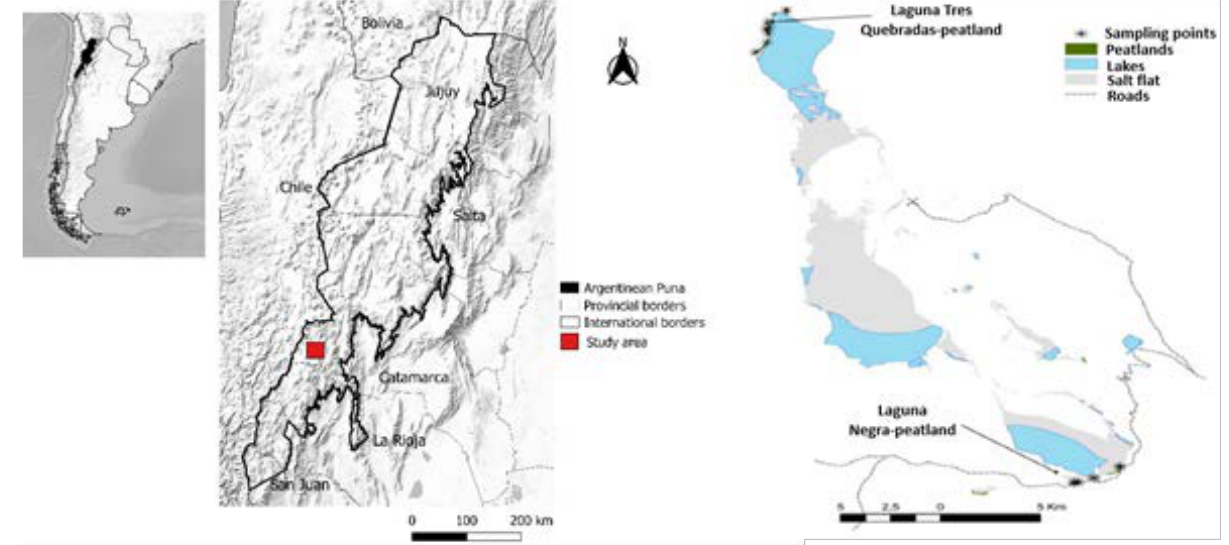
Figure 1. Location of the study area in the Puna ecoregion, within Catamarca province in Argentina (left). Salt flat associated with lakes and peatlands selected for this study (right). Peatland associated with Laguna Tres Quebradas is located at the northern, and peatland associated with Laguna Negra is located at the southern edge of the salt